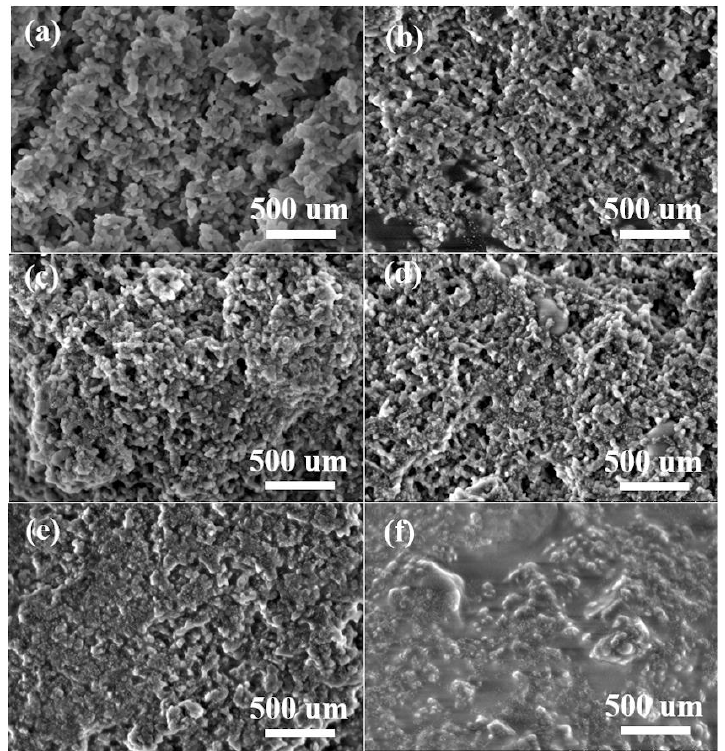
Figure 10. SEM images of recovered CaMgAl-LDOs at different reaction temperatures: ( a ) fresh sample; ( b ) at 400 °C; ( c ) at 500 °C; ( d ) at 600 °C; ( e ) at 700 °C; ( f ) at 800 °C.